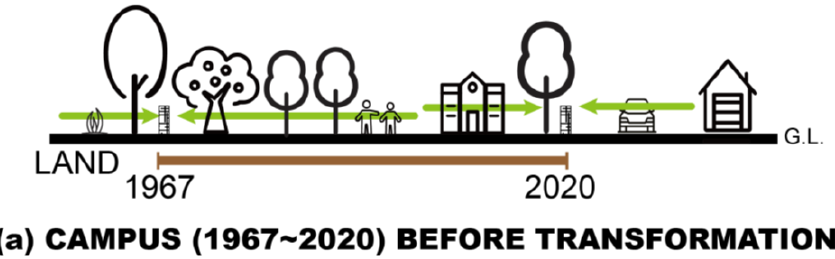
Figure 17. Campus Transformation of Pingtung Education Innovation Unit.